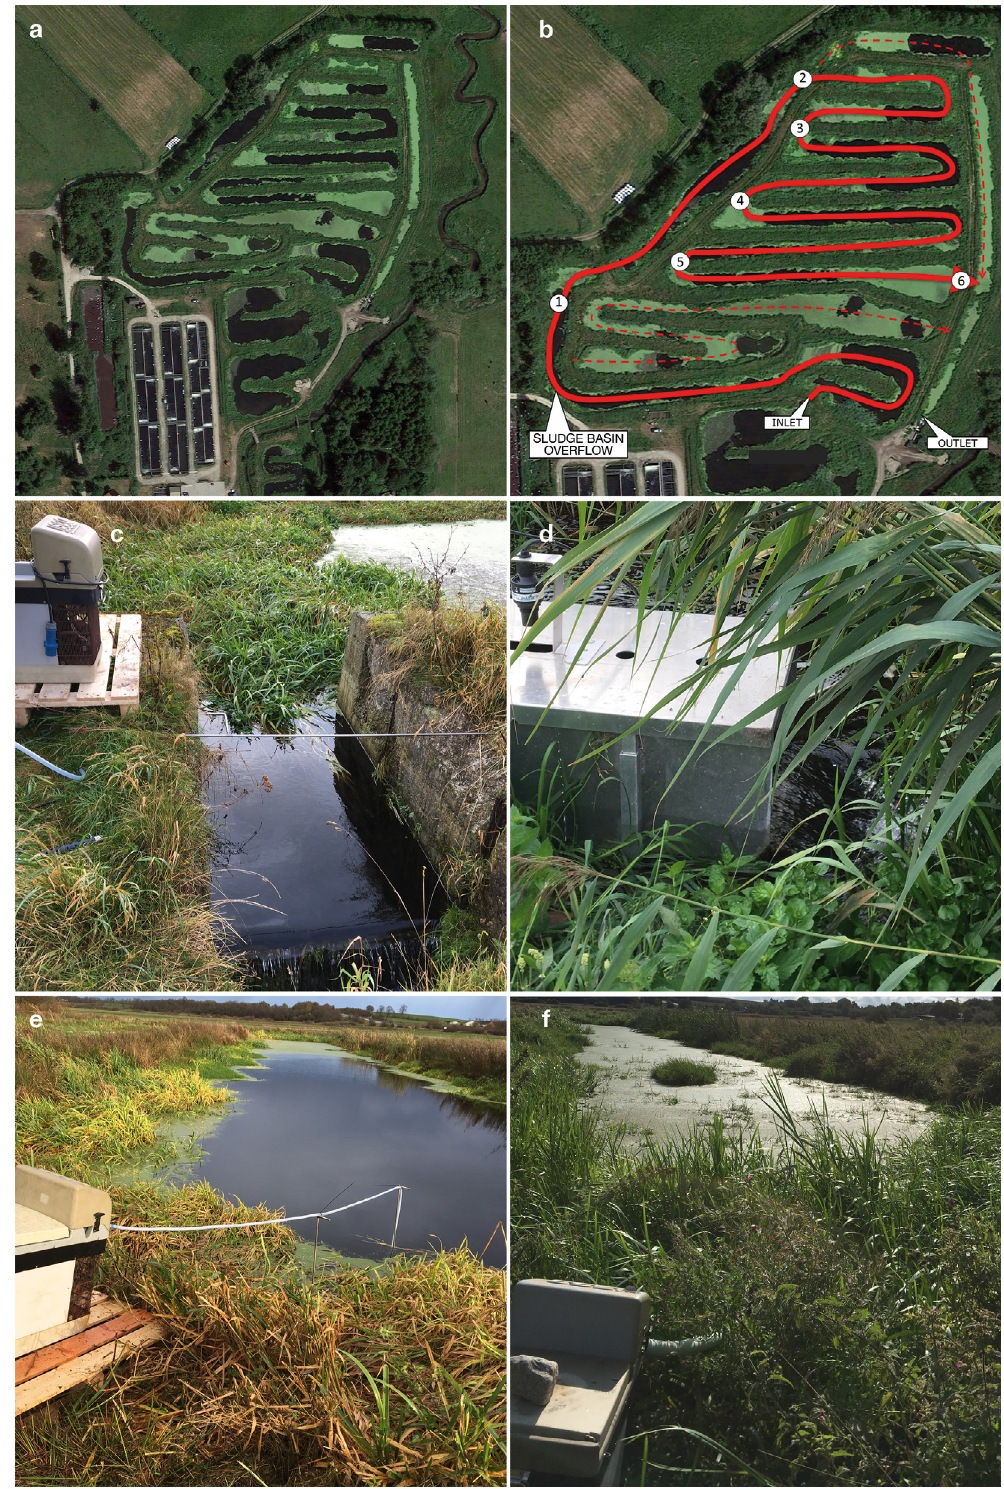
Fig. 1. (a,b) Google Maps pictures (https://www.google.ca/maps/@56.9984115,9.6734967,494m/data=!3m1!1e3) of the study site including (a) the model trout farm and associated constructed wetland and (b) a close-up of the monitored wetland section (solid red line) and position of sampling Stns 1 to 6, with dotted red lines indicating wetland sections purposely ligated during the study. Also shown are (c) the inlet, (d) the outlet, (e) Stn 5 in November 2017, and (f) Stn 5 in August